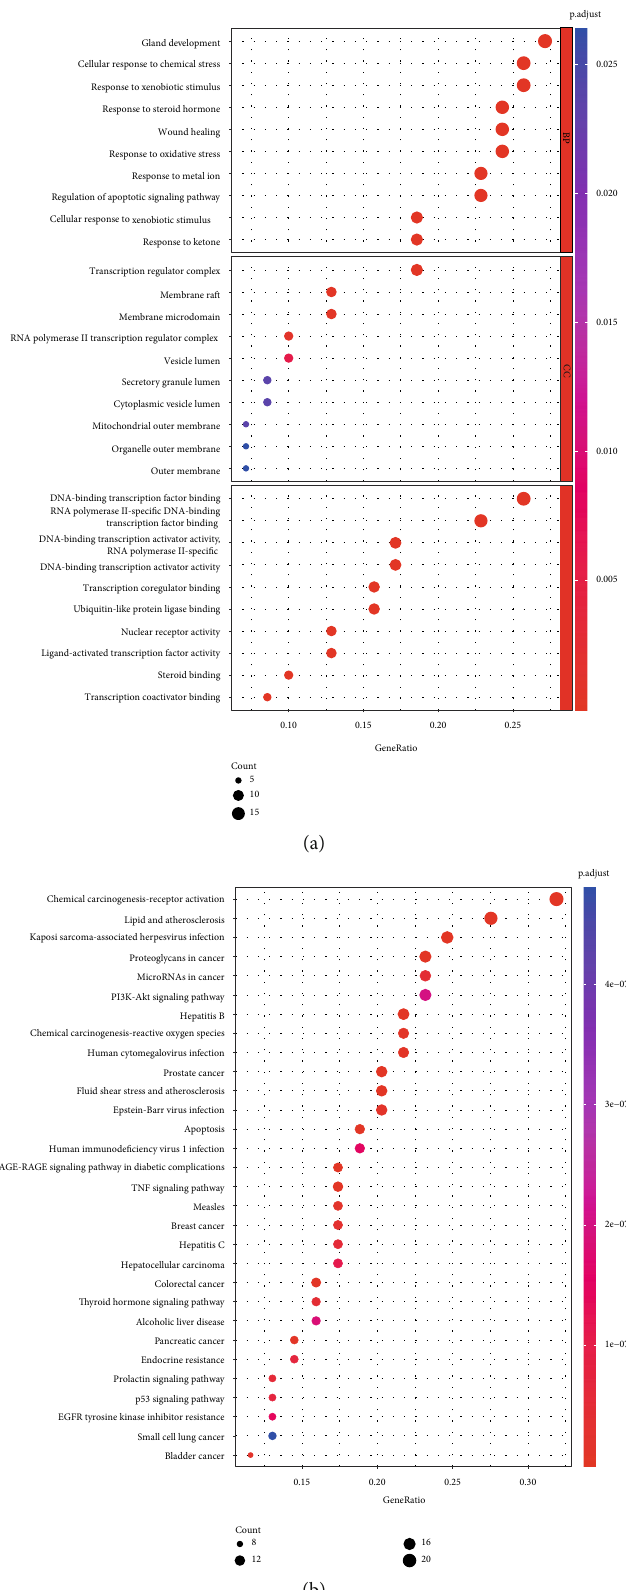
Figure 5: The top 10 most enriched GO terms at the levels of BP, CC, and MF (a) and the top 20 most enriched KEGG pathways (b), presented by bubble